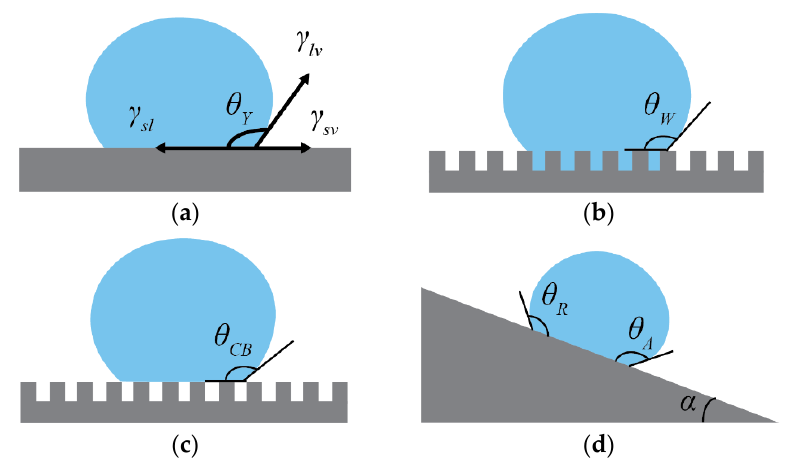
Figure 1. ( a ) Young’s equation; ( b ) Wenzel state; ( c ) Cassie–Baxter state; ( d ) water droplet on an incline, showing advancing and receding contact angle and sliding angle.